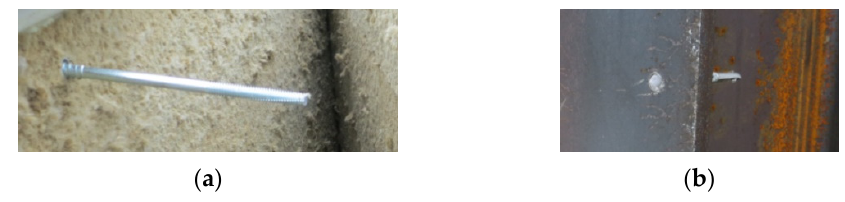
Figure 11. Tear failure of the internal facing in the vicinity of the fasteners.